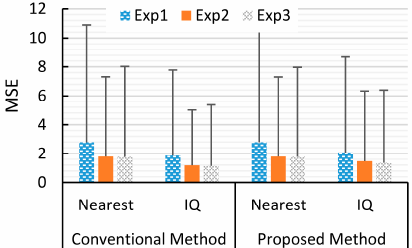
Figure 9. The bar graph of the MSEs between the reference ultrasound images and the reconstructed images using four different combinations of schemes: the conventional and proposed methods; and the nearest sample and the I/Q interpolation method. The upper error bars show one standard deviation of the squared errors. Note that the range of the ultrasound images is from 0 to − 80 dB. The time for uploading the digitized echo data to the GPU is around 8.31 ms (for 42.5 MBytes = 8192 samples × 32 receive signals × 81 scanlines × 2 bytes of short int ). The time for downloading the results from the GPU is around 1.14 and 0.61 ms, respectively, for the FP64 format (5.3 MBytes = 8192 samples × 81 scanlines × 8 bytes of double ) and for the FP32 format (2.65 MBytes = 8192 samples × 81 scanlines × 4 bytes of float ). These times are averaged from the recorded times of all tested schemes.